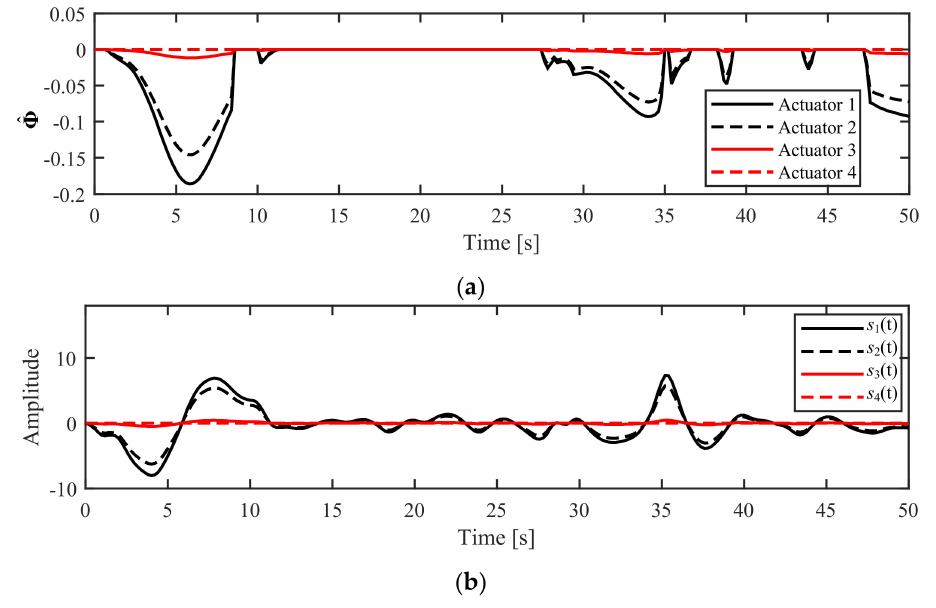
Figure 29. The performance of the proposed controller: ( a ) The updating switching gains of the ASTSMC-TDE (ASMC term); ( b ) Sliding manifold